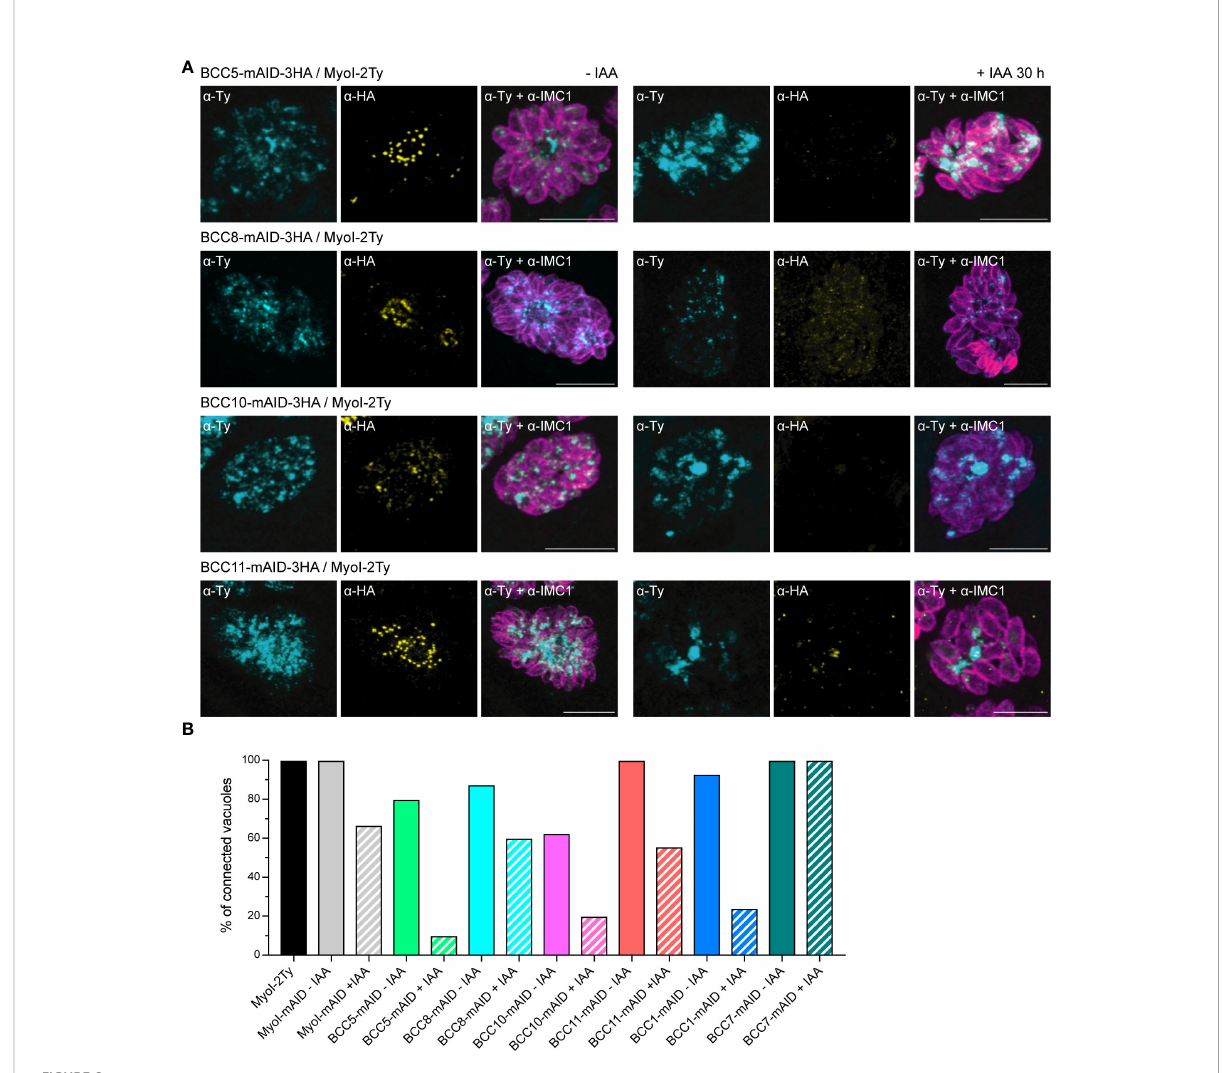
FIGURE 8 BCC5, BCC8, BCC10, and BCC11 depletion impacts the rosette organization of the parasites and their intravacuolar connection. (A) Immuno- detection of MyoI endogenously tagged (MyoI-2Ty) in an auxin-inducible knockdown of BCC5, BCC8, BCC10, and BCC11 assessed by IFA after 30 h treatment with or without 500 m M of IAA. Magenta: IMC1, Yellow: BCC of interest, Cyan: MyoI. Scale bars: 10 m m. (B) Percentage of vacuoles in which the parasites were connected to each other ’ s. This was assessed by FRAP experiment using the soluble GFP as a reporter of diffusion. See Supplementary Figure 5 for the signi fi cance of the results (representative vacuoles for “ connected ” and “ non-connected ” as well as for the number of bleached